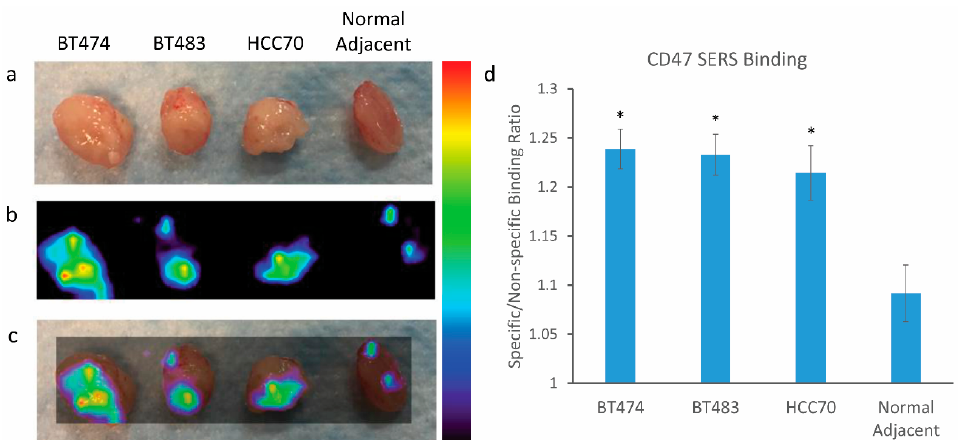
Figure 7. Raman imaging of breast cancer tissues and normal adjacent tissue harvested from mouse xenograft. ( a ) Digital photo of excised tissue after NPs administration; ( b ) Raman imaging of tissue samples; ( c ) overlay of Raman imaging with tissue sample, notice the increased NP binding in the breast cancer tissue as opposed to the normal adjacent tissue; ( d ) quantitative ratiometric analysis of specific CD47 SERS NP binding to non-specific Isotype IgG SERS NP binding on each of the tissue samples. Notice the significant differences represented by * ( p < 0.05) between the cancer tissue and the normal adjacent tissues; error bars represent standard error of mean (SEM). Color bar to the right of the Raman images represents Raman intensity, where red represents the highest Raman signal and black represents no associated Raman signal.